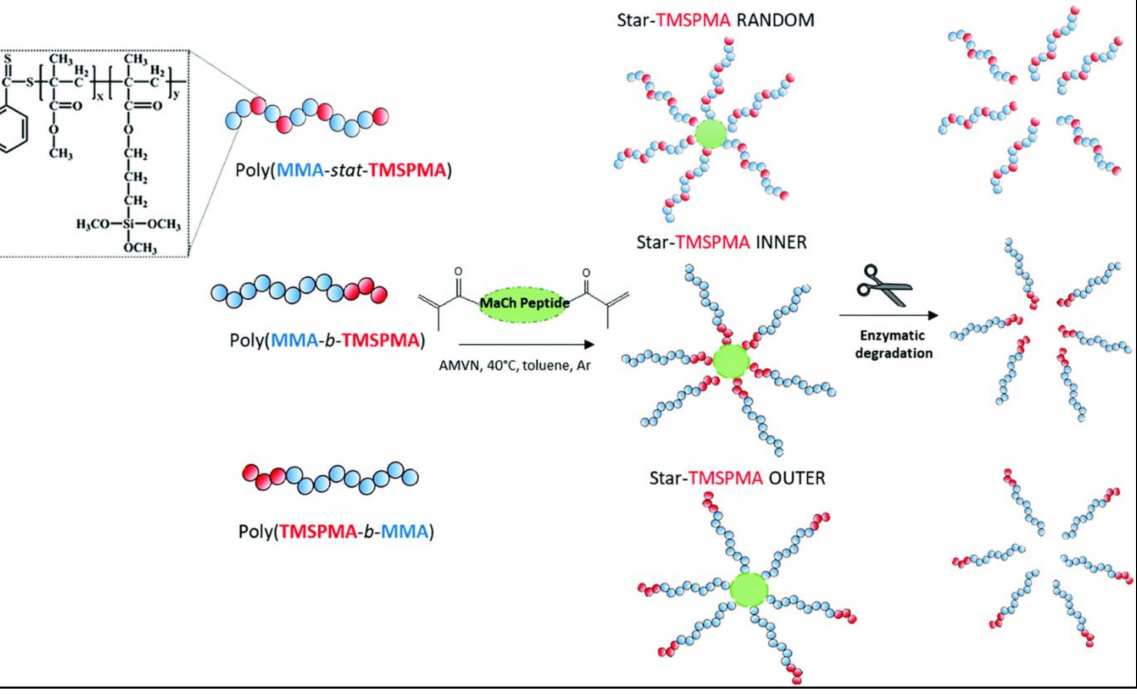
Figure 10. Illustration of the enzymatic degradation process [81].